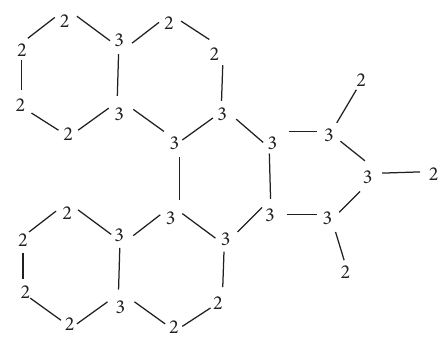
Figure 10: D [ 1 ] along with the degree of each 2